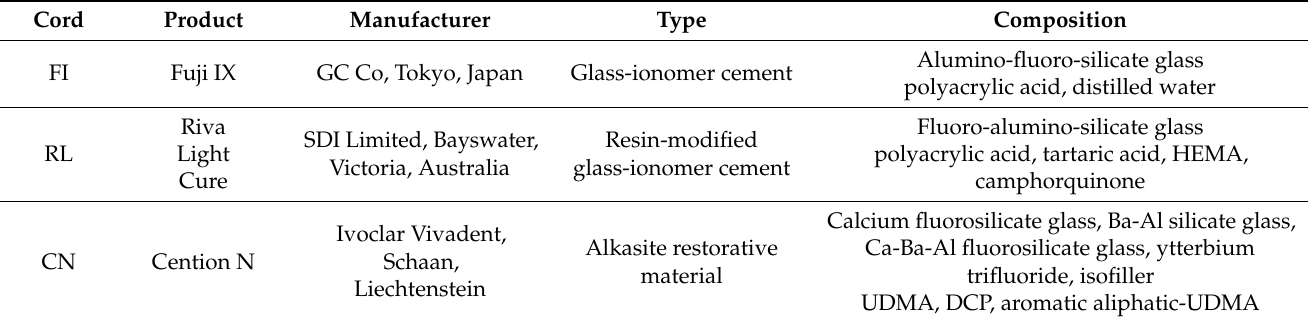
Table 1. Fluoride-releasing restorative materials investigated in this